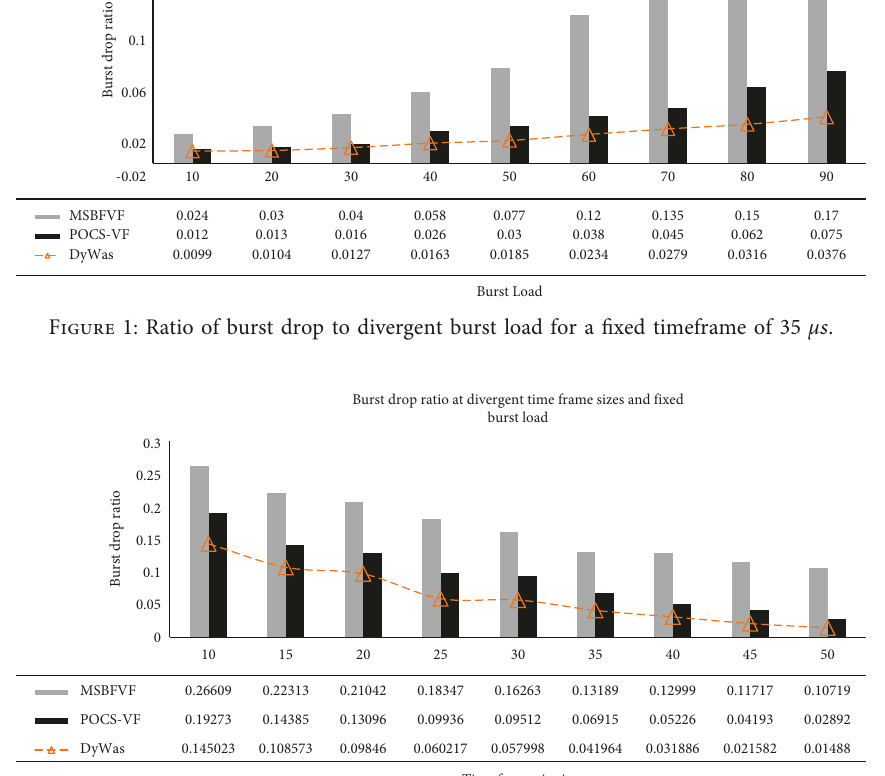
Figure 2: Burst drop ratio changing with the change of size of the timeframes and the burst size staying the same.